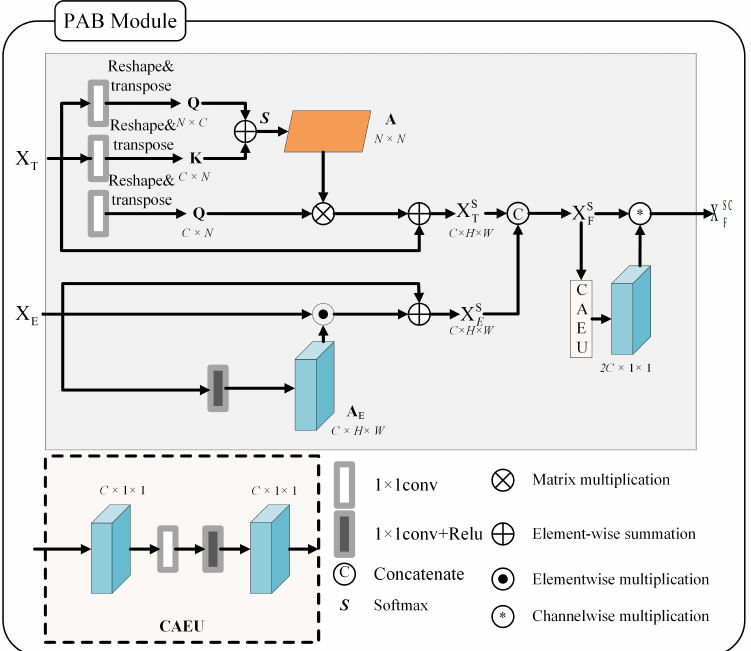
Figure 6. The parallel attention block (PAB). The PAB is designed to transfer important information to the line branch output (X SC ). The pink box in the lower-left corner shows the structure of the F